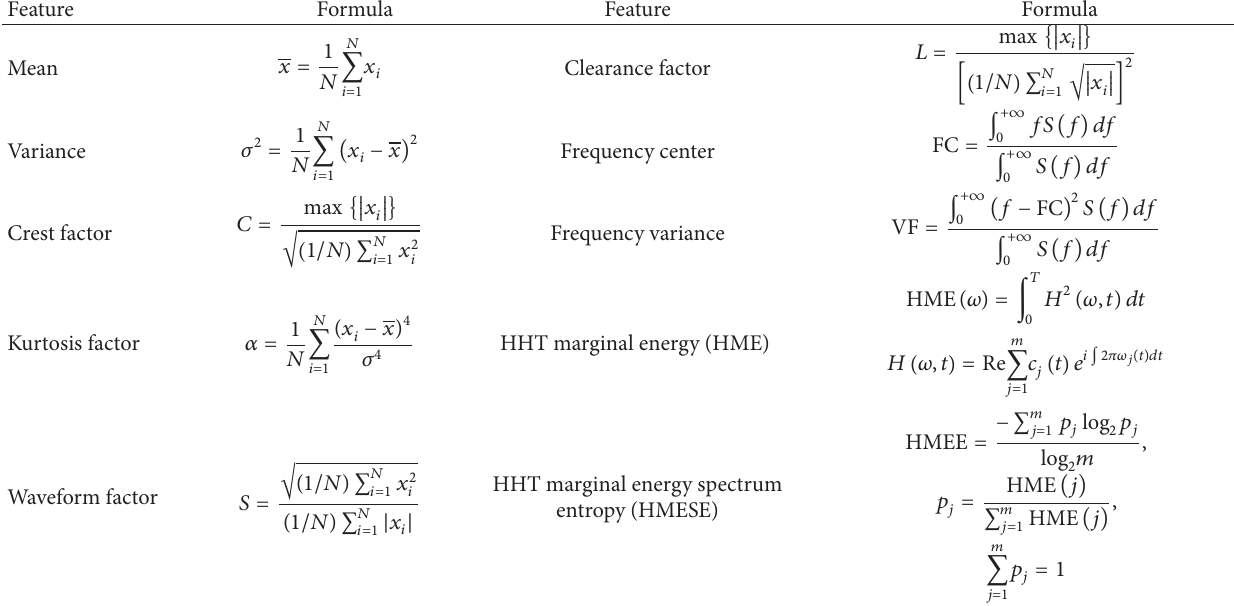
Table 1: Candidate degradation